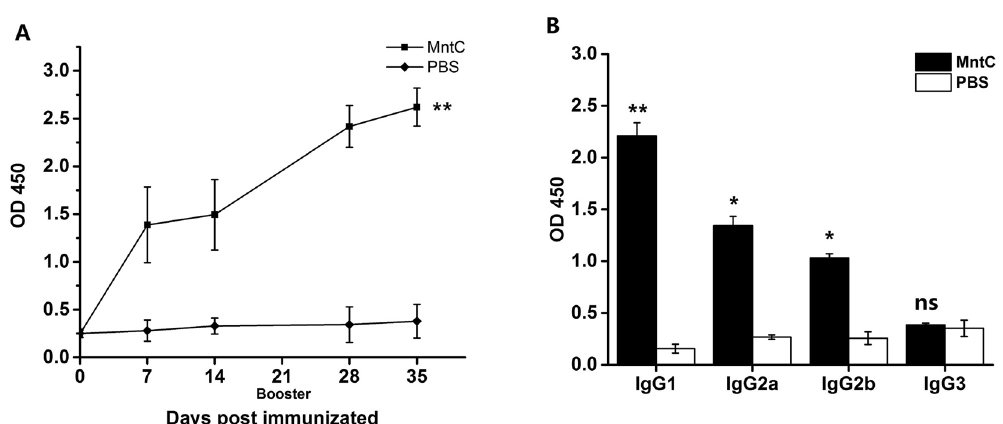
Figure 2. Active immunization with recombinant MntC induced specific IgG production. Female BALB/c mice (n = 4) were intramuscularly immunized with purified MntC. Seven days after the booster immunization, the mice were bled, and the sera were tested by ELISA for anti-recombinant protein antibodies. The titres were determined for ( A ) IgG, ( B ) IgG1, IgG2b, and IgG3. The results represent the mean and standard error of each group of mice. Significant differences were indicated by ( * P < 0.05), ( ** P < 0.01) and ( *** P <